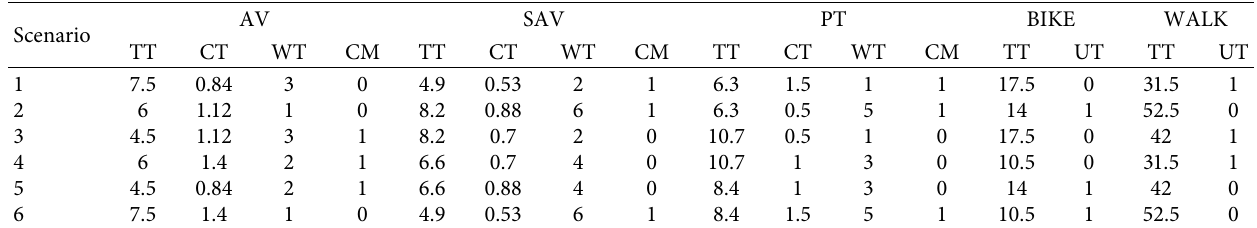
Table 3: Example of scenarios selected using the D-Error technique for a 2 to 5km